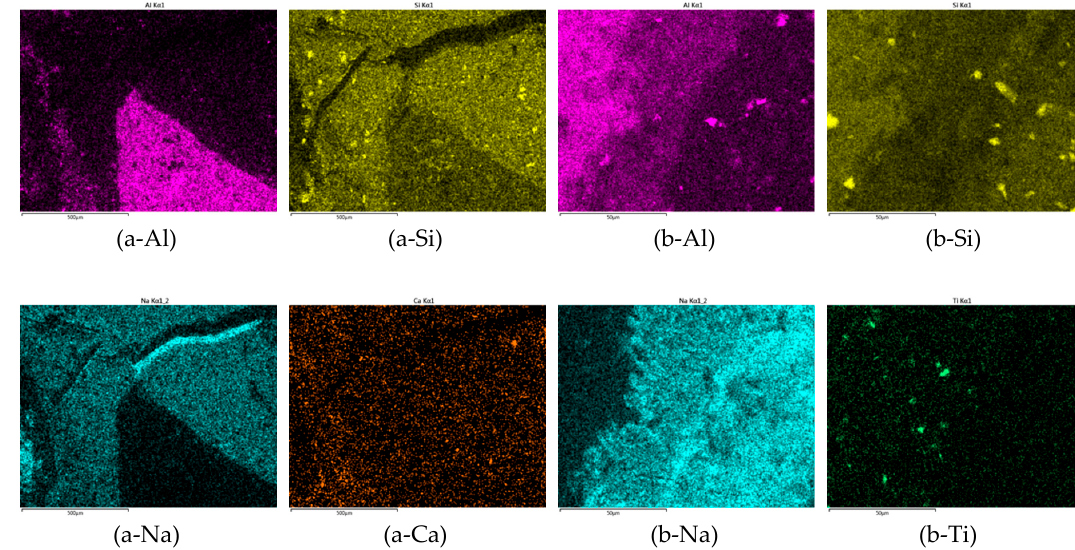
Figure 8. SEM micrograph of alkali activated material prepared from precursor’s fraction 2 mm < x ≤ 4 mm with magnification of ( a ) 100 and ( b ) 1000. EDXS mapping is presented in (b-chemical element) of area (b).